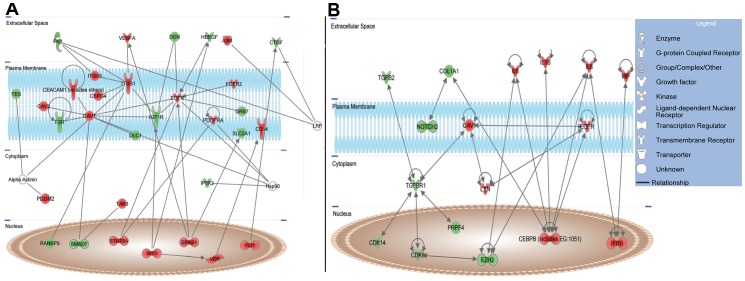
Networks related to proliferation (A) and cell-cycle regulation (B) according to Ingenuity Pathway (IPA).Differentially expressed genes which by functional analysis were associated to (A) proliferation or (B) cell cycle analysis were uploaded into IPA. Genes were overlaid onto a global molecular network developed from information contained in the Ingenuity® Knowledge Base. The obtained networks were algorithmically generated based on the connectivity of differentially expressed genes. The networks also reveal the relationship between different genes and their subcellular distribution according to IPA score from published data. Red symbols denote upregulated genes and green symbols denote downregulated genes.